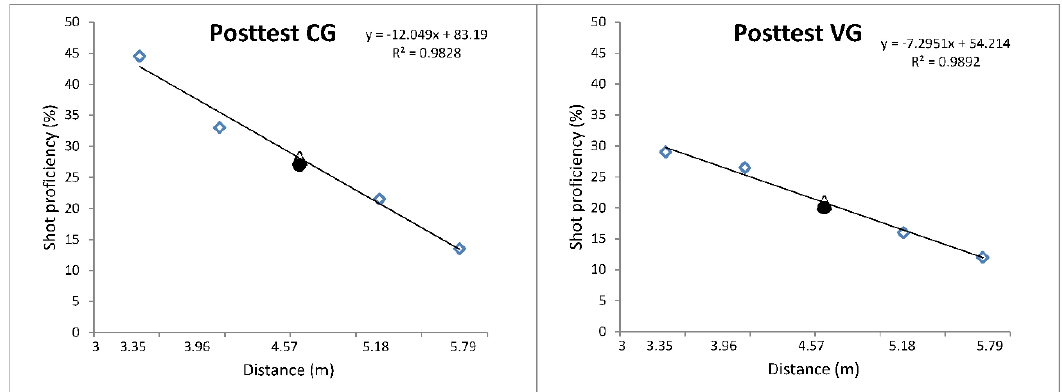
Figure 1. Posttest average shot proficiency across the 3.35, 3.96, 4.57, 5.18, and 5.79 m distances from the basket. The non-filled triangles illustrate the expected shot proficiency values at the 4.57 m distance, based on linear regression. Filled black circles represent real values (shot proficiency) at a distance of 4.57 m from the basket. The non-filled diamonds represent mean shot efficiencies at all distances but 4.57 m.